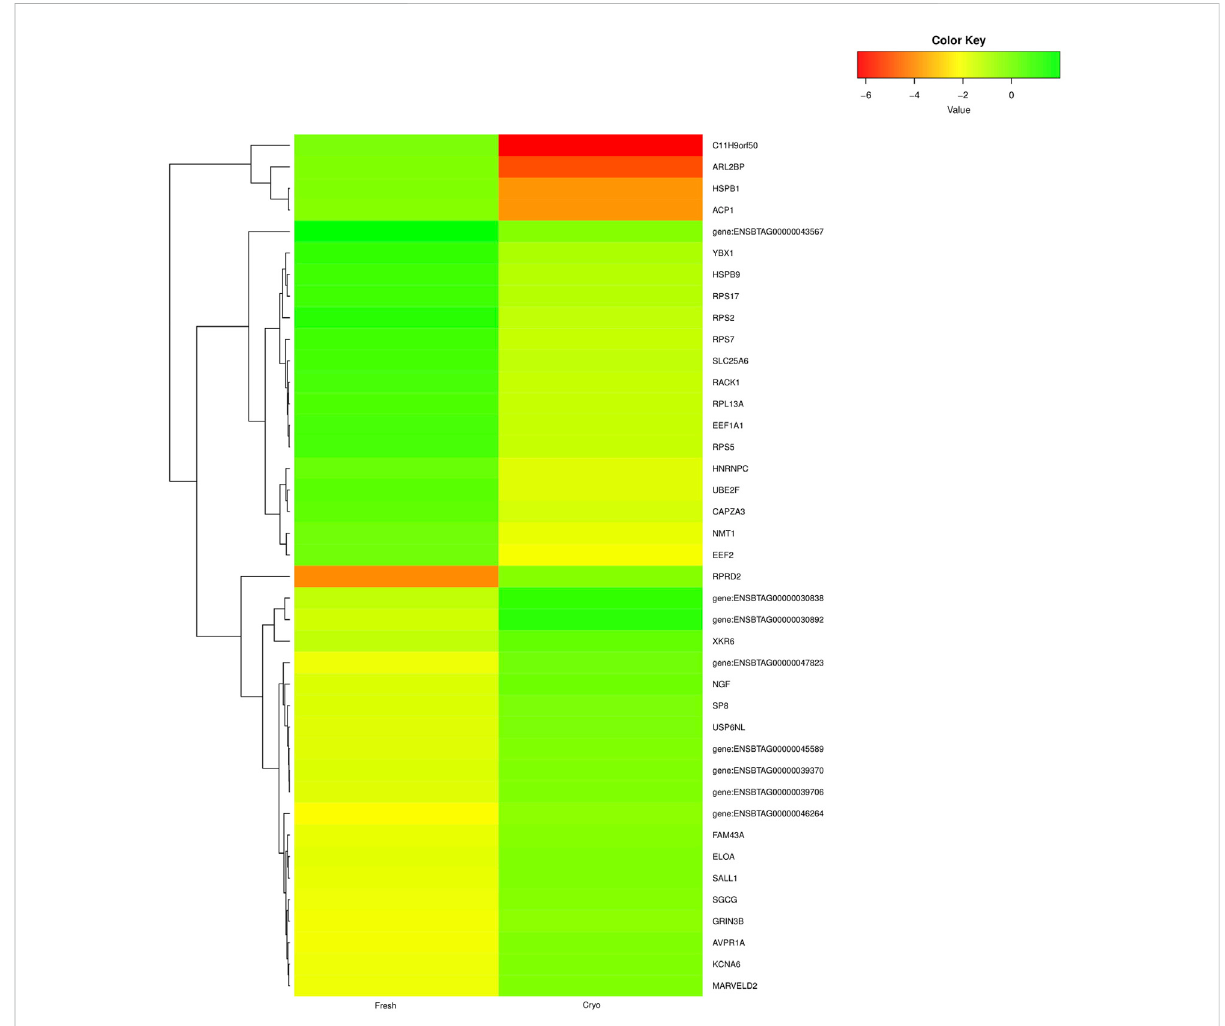
FIGURE 3 Heat map representing the top 20 upregulated (green) and top 20 downregulated (red and yellow) genes in cryopreserved spermatozoa compared to fresh